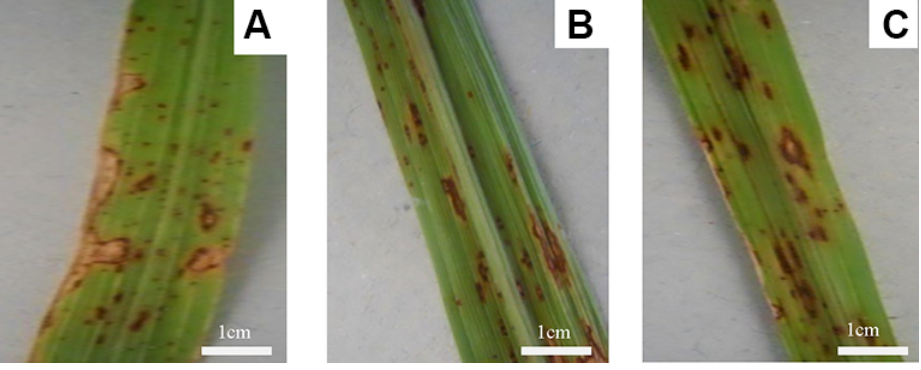
Figure 4 e symptoms of rice leaves artificially inoculated with spore suspensions of Bipolaris oryzae ; ( A ) Taibonet variety, ( B ) Eurano variety, and ( C ) Cererrer variety.